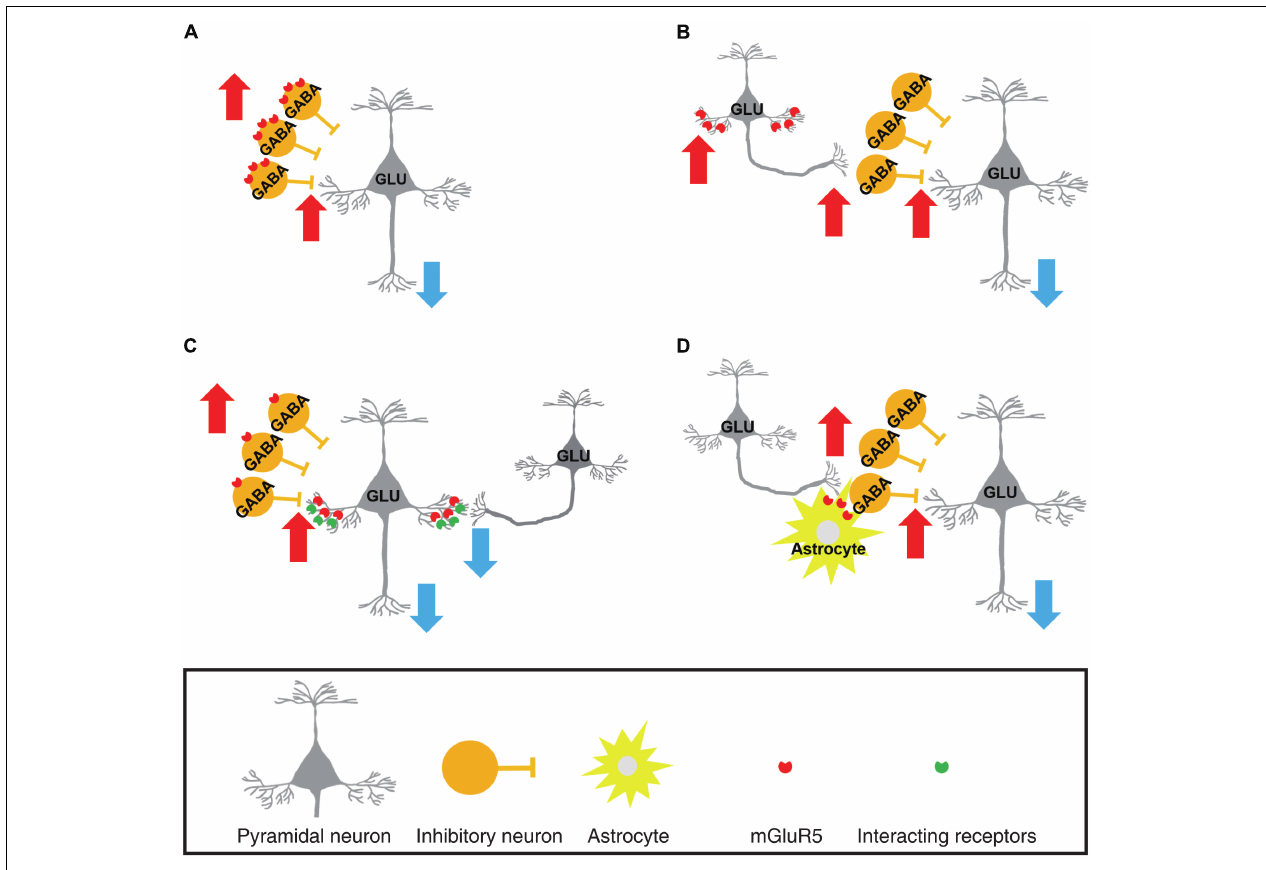
FIGURE 1 | Schematic drawings representing possible cellular subsets of which metabotropic glutamate receptor 5 (mGluR5) upregulation occurs in the chronic pain state. In these scenarios, enhanced mGluR5 levels in the layer 5/6 medial prefrontal cortex (mPFC) were assumed to result in suppression of prelimbic pyramidal neurons. (A) mGluR5 is upregulated in the GABAergic inhibitory interneurons. As a result, GABAergic neuronal activity is increased. (B) mGluR5 is increased in the specific subpopulation of pyramidal neurons that preferentially excite local GABAergic neurons. (C) Layer 5/6 pyramidal neurons express more mGluR5. However, the increased mGluR5 suppresses, rather than facilitates, pyramidal neuronal activity. This is achieved by an enhancement of long-term depression in excitatory synapses and concurrent loss of presynaptic modulation by mGluR5. (D) mGluR5 upregulation occurs in astrocytes surrounding the synapses of a specific subpopulation of mPFC neurons. The increased glial mGluR5 serves to enhance excitatory influences on GABAergic neurons. (GLU, glutamatergic neuron, GABA, GABAergic